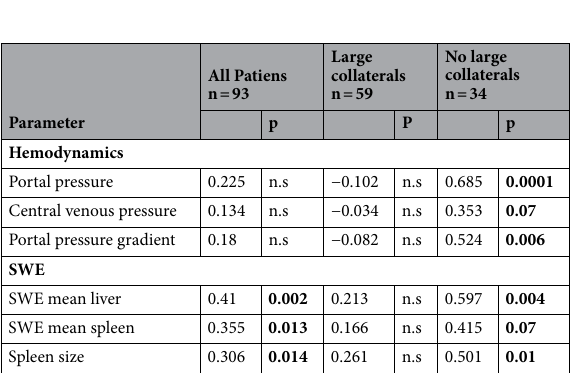
Table 3. Correlation of cisterna chyli diameter and patients characteristics. Statistically significant values (p < 0.05) are shown in